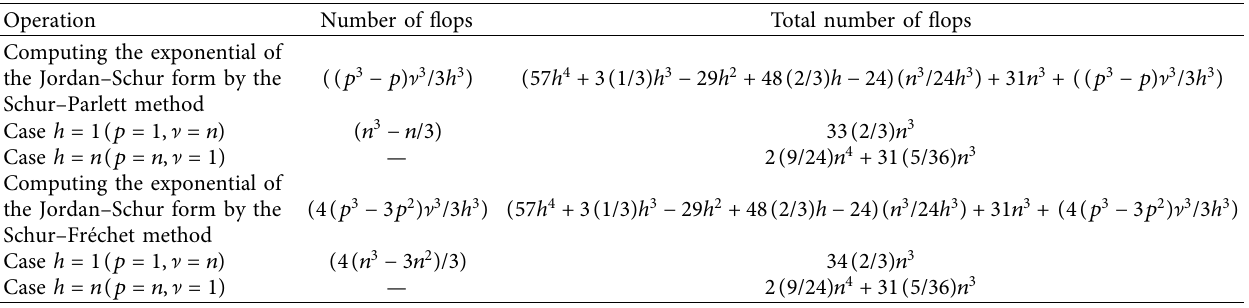
Table 2: Number of computational operations required by the Schur–Parlett and Schur–Fr´echet algorithm. Operation Number of fops Total number of fops Computing the exponential